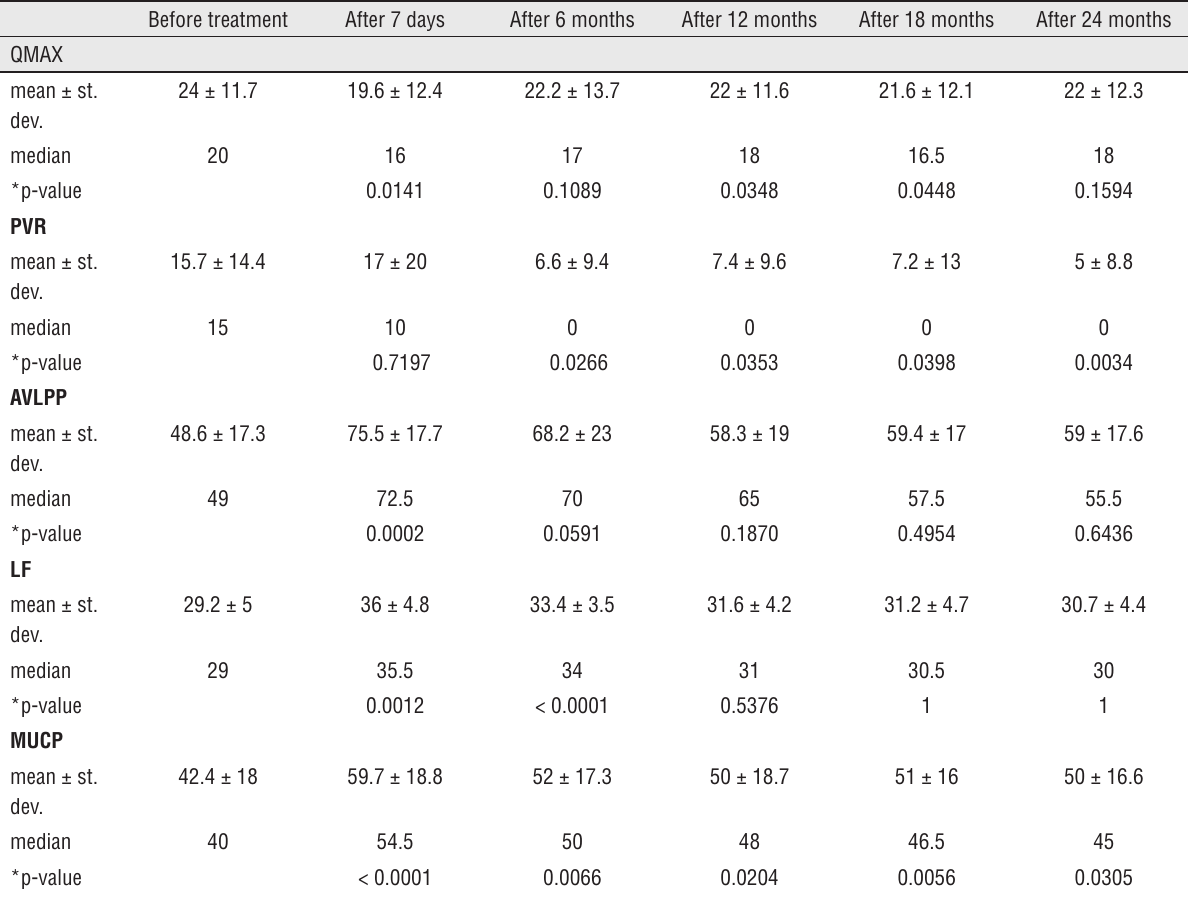
Table 4 - Urodynamic findings before and after treatment with Bulkamid®. Before treatment After 7 days